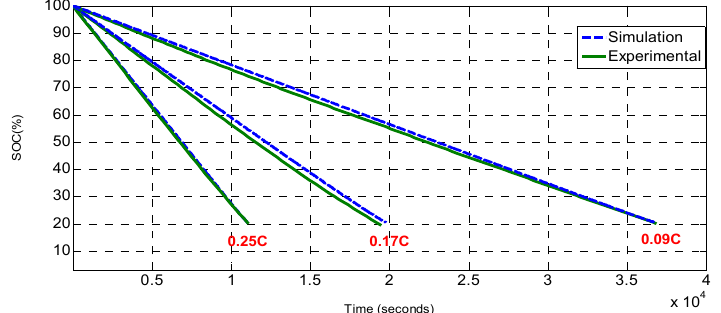
Figure 7. The SOC as a function of time at fixed C rates.